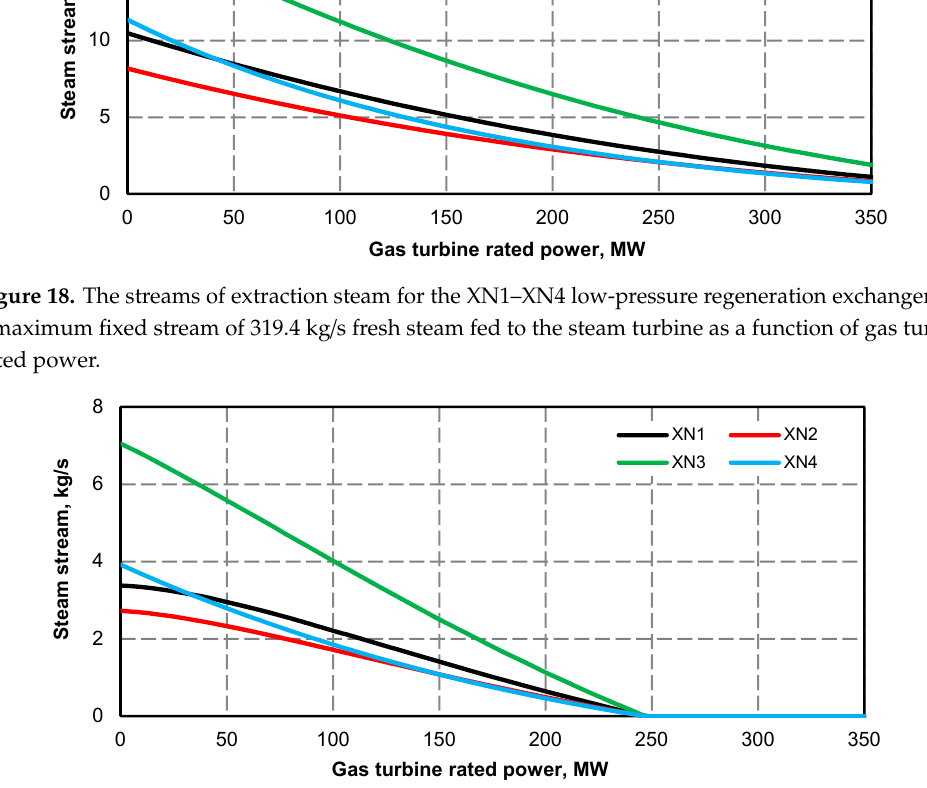
Figure 19. The streams of extraction steam for the XN1–XN4 low-pressure regeneration exchangers for a minimum steam boiler output of 133.3 kg/s and a gas turbine operating at a rated power.